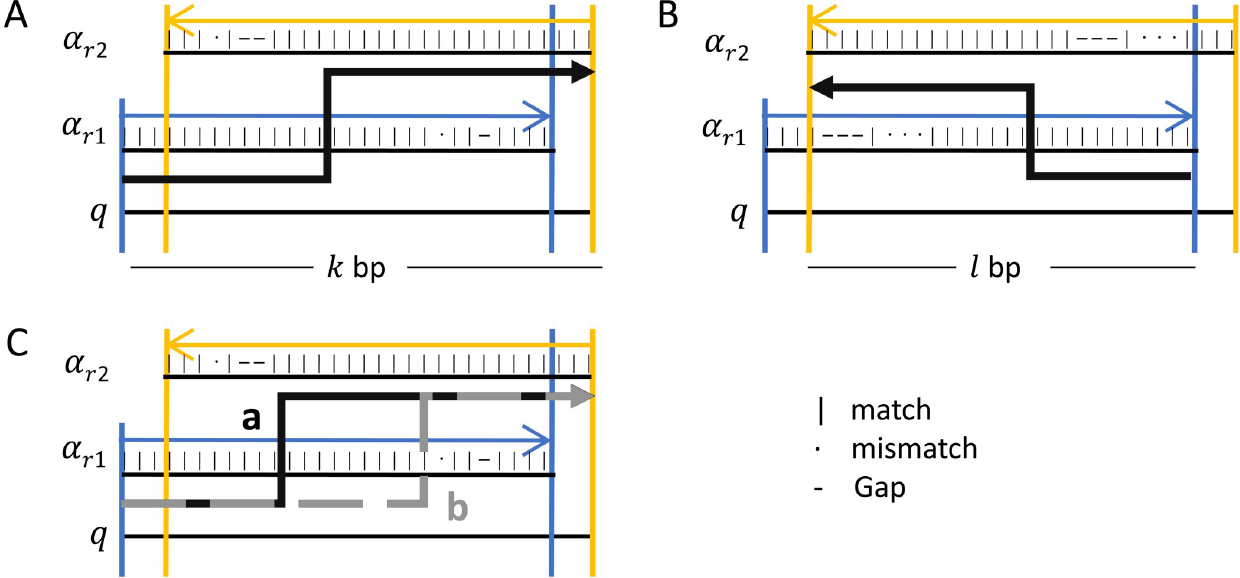
Fig 6. Overlapping subsequences of read. Schematic representation of a pair of alignments of the same read when the aligned read subsequences are overlapping. The pair is examined for all possible orientations to find the higher possible score (A and B). Once the best orientation is identified, the maximum score path is calculated detecting the corresponding breakpoint on the read (C). Different combinations of the orientation of each alignment corresponds to a different type of DVG.